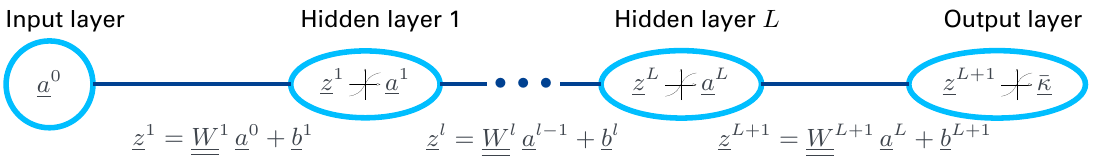
Figure 3. The basic functionality of a dense feedforward neural network is depicted in simplified